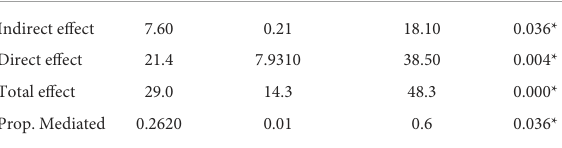
TABLE 4 Mediation analysis for the volume of left mOFC and the relationship between rsFC (the left mOFC-rSOG) and DEBQ-external